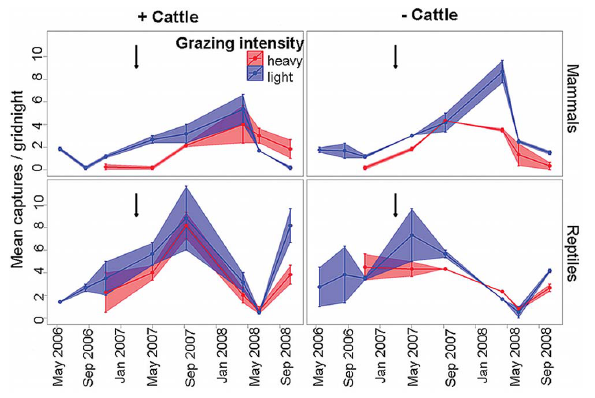
Figure 4. Captures (mean ± SE) of all vertebrates under different grazing histories and cattle removal treatments. Captures are averaged per gridnight and historic grazing intensities are ‘light’ and ‘heavy’ and cattle removal treatments are ‘ + cattle’ and ‘ 2 cattle’. Only the trips from 2007 on, that is trips when balanced data sets were obtained (May 2007, September 2007, April 2008, June 2008 and October 2008), are used in the statistical analyses, but trips prior to 2007 are presented to give an overview of temporal trends. Arrows indicate heavy rainfall.